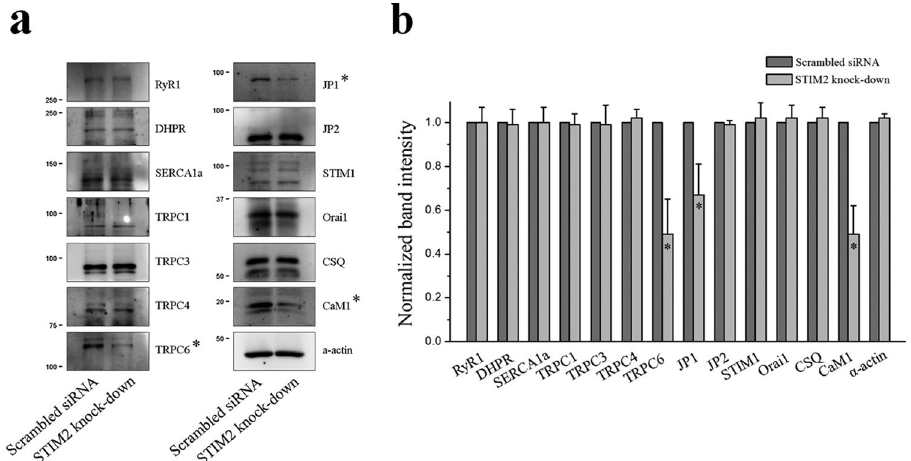
Figure 6. Decreased protein content level of TRPC6, JP1, or CaM1 by STIM2-knockdown. ( a ) Lysate of the STIM2-knockdown myotubes was subjected to an immunoblot assay with one of the antibodies against thirteen proteins that mediate or regulate skeletal muscle functions. α -Actin was used as a loading control. Three independent experiments per each protein were conducted. JP, junctophilin; CSQ, calsequestin. The immunoblot data were cropped from the immunoblot images of different gels and were grouped. The full- length blots are presented in Supplementary Figs 6 to 19. Among them, the expression level of TRPC6, JP1, or CaM1 was significantly decreased (indicated by asterisks). ( b ) The protein content level in (a) is presented as bar graphs. Bar graphs are presented as the mean ± S.E. for three independent experiments. * Significant difference compared with the scrambled siRNA control ( P < 0.05). The protein content level of TRPC6, JP1, or CaM1 in the STIM2-knockdown myotubes was significantly